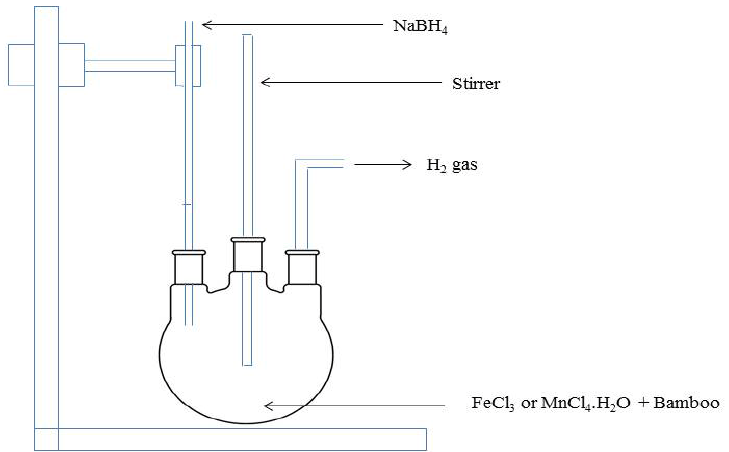
Figure 8. Schematic diagram for the synthesis of nZVI-bamboo and nMn-bamboo